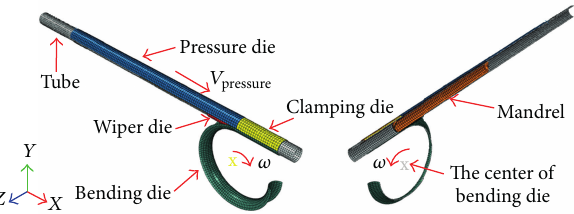
Figure 3: Finite element model for NC bending process of 2169 small diameter tube.